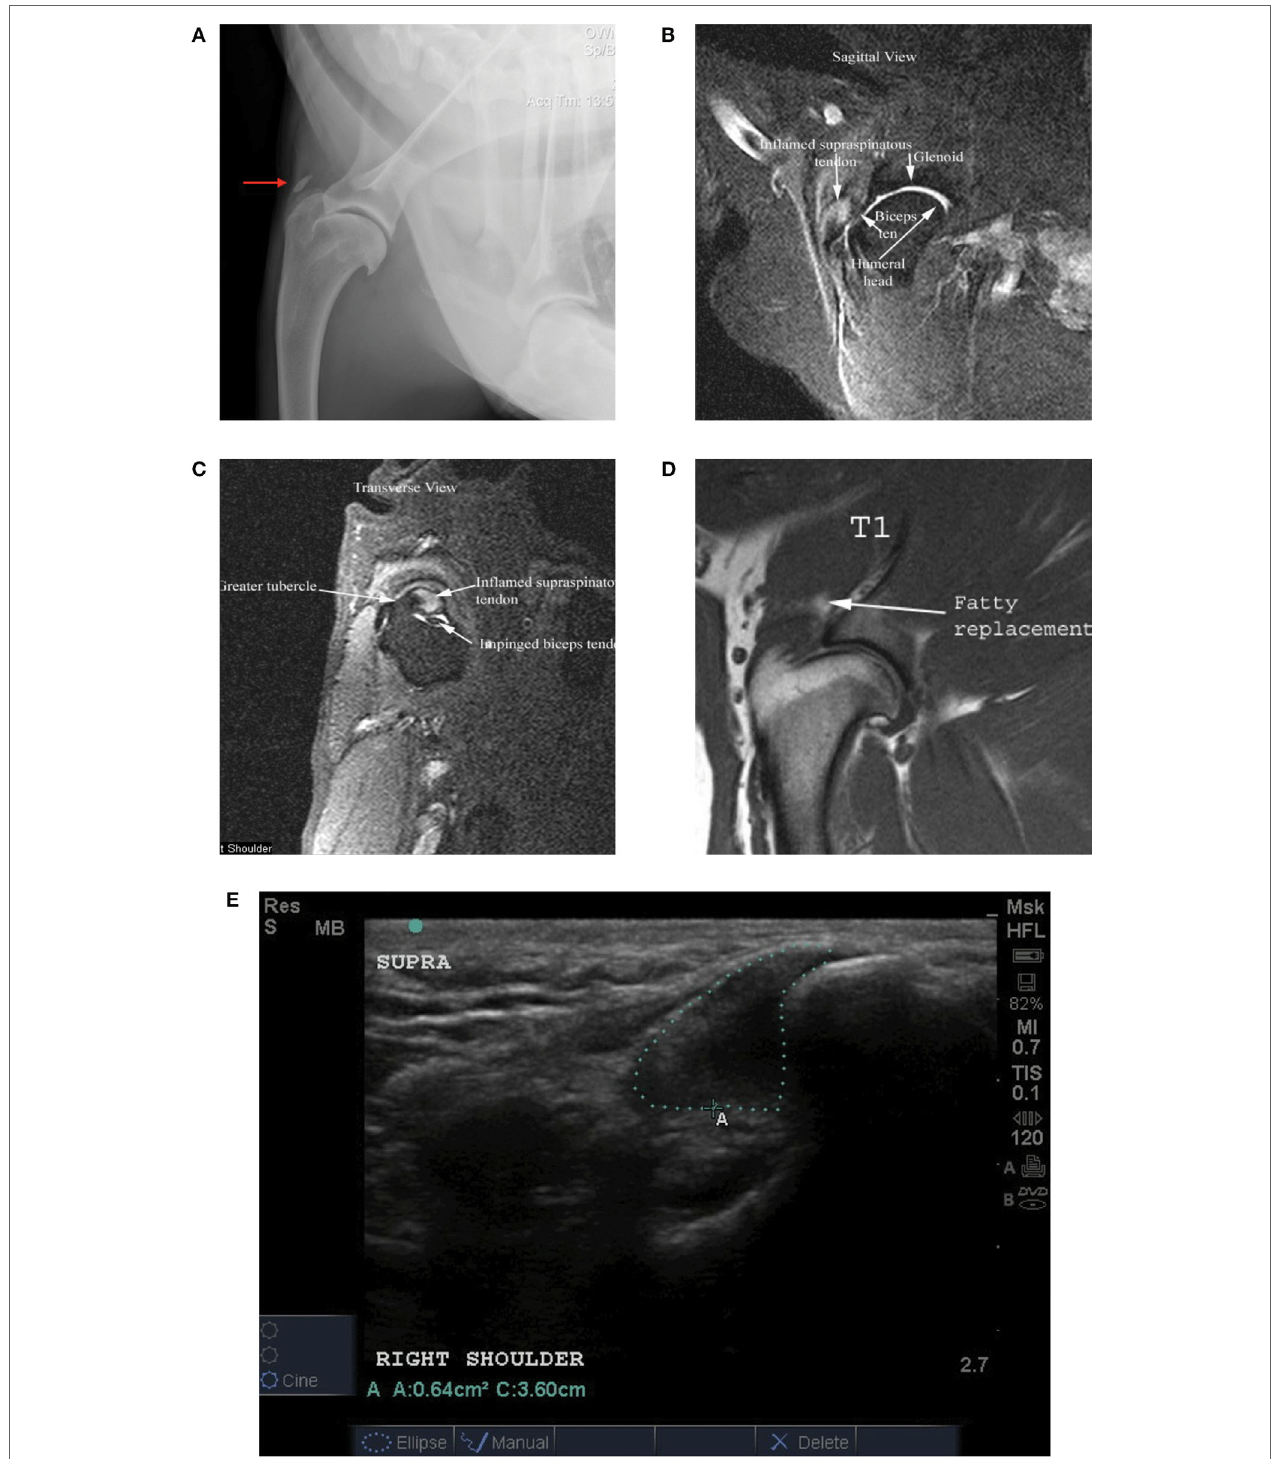
FigUre 4 | (a) Shoulder radiograph with mineralization of the supraspinatus tendon insertion (red arrow); (B) STIR sagittal image of a shoulder MRI in a patient with a supraspinatus tendinopathy showing an inflamed supraspinatus tendon; (c) STIR transverse image of a shoulder MRI in a patient with a supraspinatus tendinopathy showing a flattened or oval appearance of the biceps tendon and loss of fluid around the biceps tendon within the bicipital groove at the level of insertion of the supraspinatus; (D) T1 MRI image in a patient with a supraspinatus tendinopathy showing fatty replacement at the myotendinous junction of the supraspinatus tendon; (e) diagnostic musculoskeletal shoulder ultrasound image depicting an enlargement of the supraspinatus